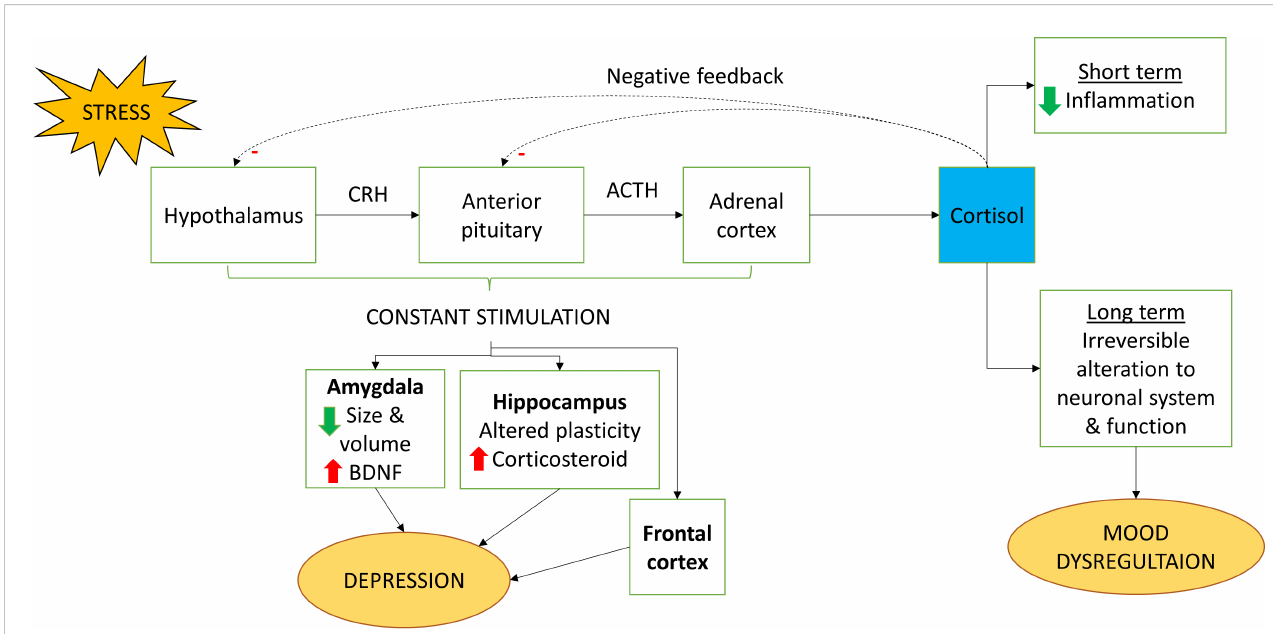
FIGURE 3 Regulation of HPA axis by IFN- a . When stimulated by stress, cortisol is being released by the HPA axis. Cortisol has short term bene fi t whereby it could reduce in fl ammation. However, long term exposure could lead to irreversible change to the neuronal system and function which causes mood dysregulation. Constant stimulation of the HPA axis also could lead to depression because of increased stimulation on the amygdala, hippocampus and frontal cortex. CRH, Corticotropin-releasing hormone; ACTH, Adrenocorticotropic hormone